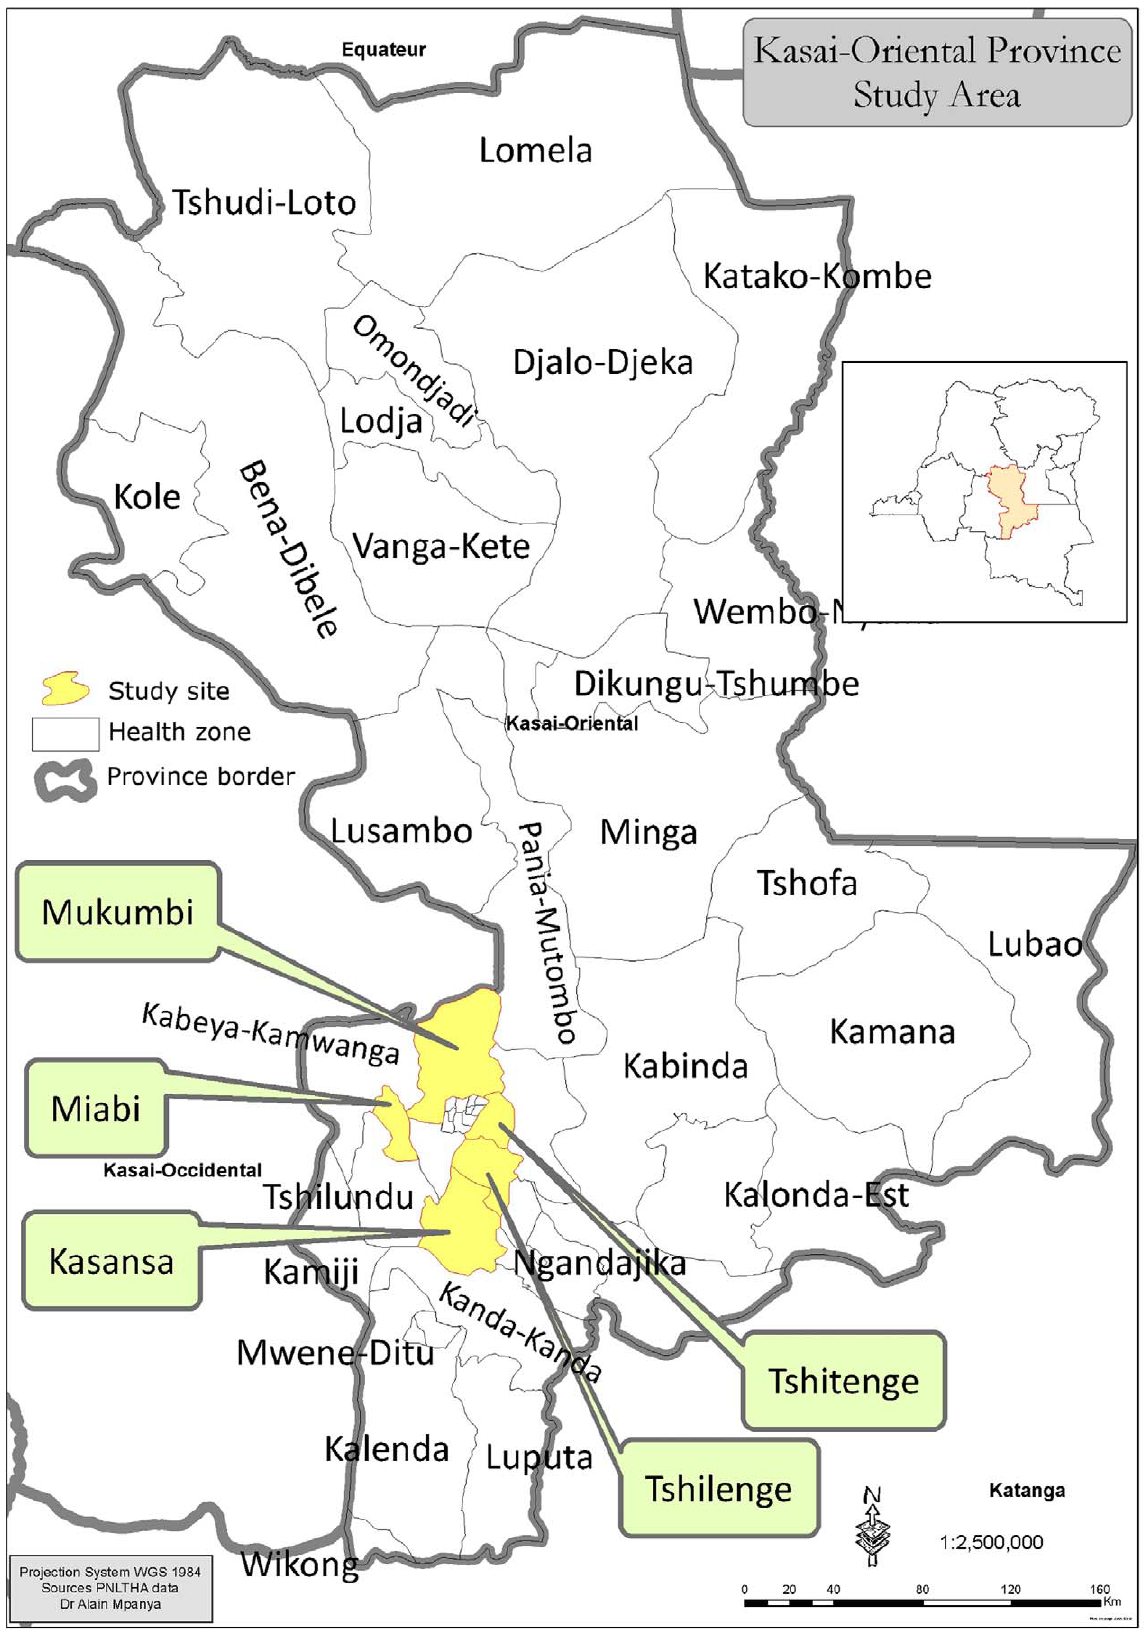
Figure 1. Geographic locations of the health zones included in the study.